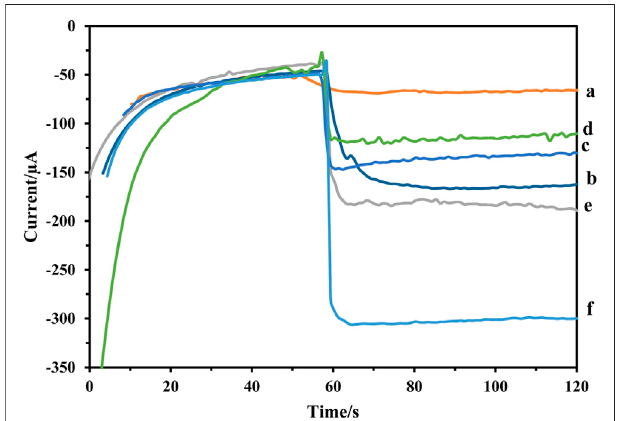
FIGURE 6 | Amperometric response of the (A) GCE, (B) GCE/Fe 3 O 4 @ TMU-24 -AuNPs, (C) GCE/Fe 3 O 4 @ TMU-24 -AuNPs/MCA/Ab 1 , (D) GCE/ Fe 3 O 4 @ TMU-24 -AuNPs/MCA/Ab 1 /HER2, (E) GCE/Fe 3 O 4 @ TMU-24 -AuNPs/MCA/Ab 1 /HER2/CdTe QDs -Ab 2 , and (F) GCE/Fe 3 O 4 @ TMU- 24 -AuNPs/MCA/Ab 1 /HER2/Pt:CdTe QDs -Ab 2